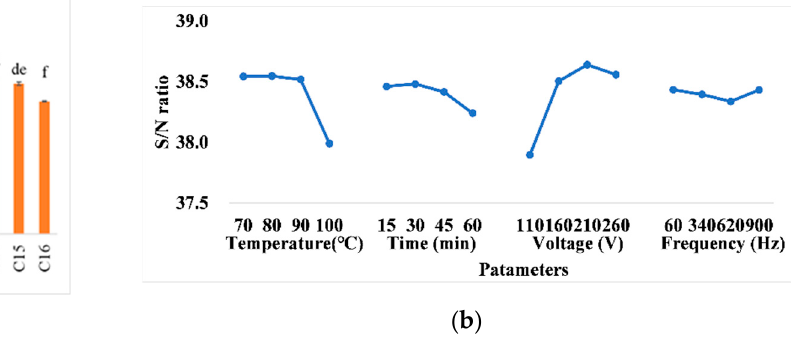
15, 260, and 340; 14: 100, 30, 210, and 60; 15: 100, 45, 160, and 900; and 16: 100, 60, 110, and 620. The same letters show insignificant differences in the same rows ( p < 0.05). The results are reported as means ± SD.